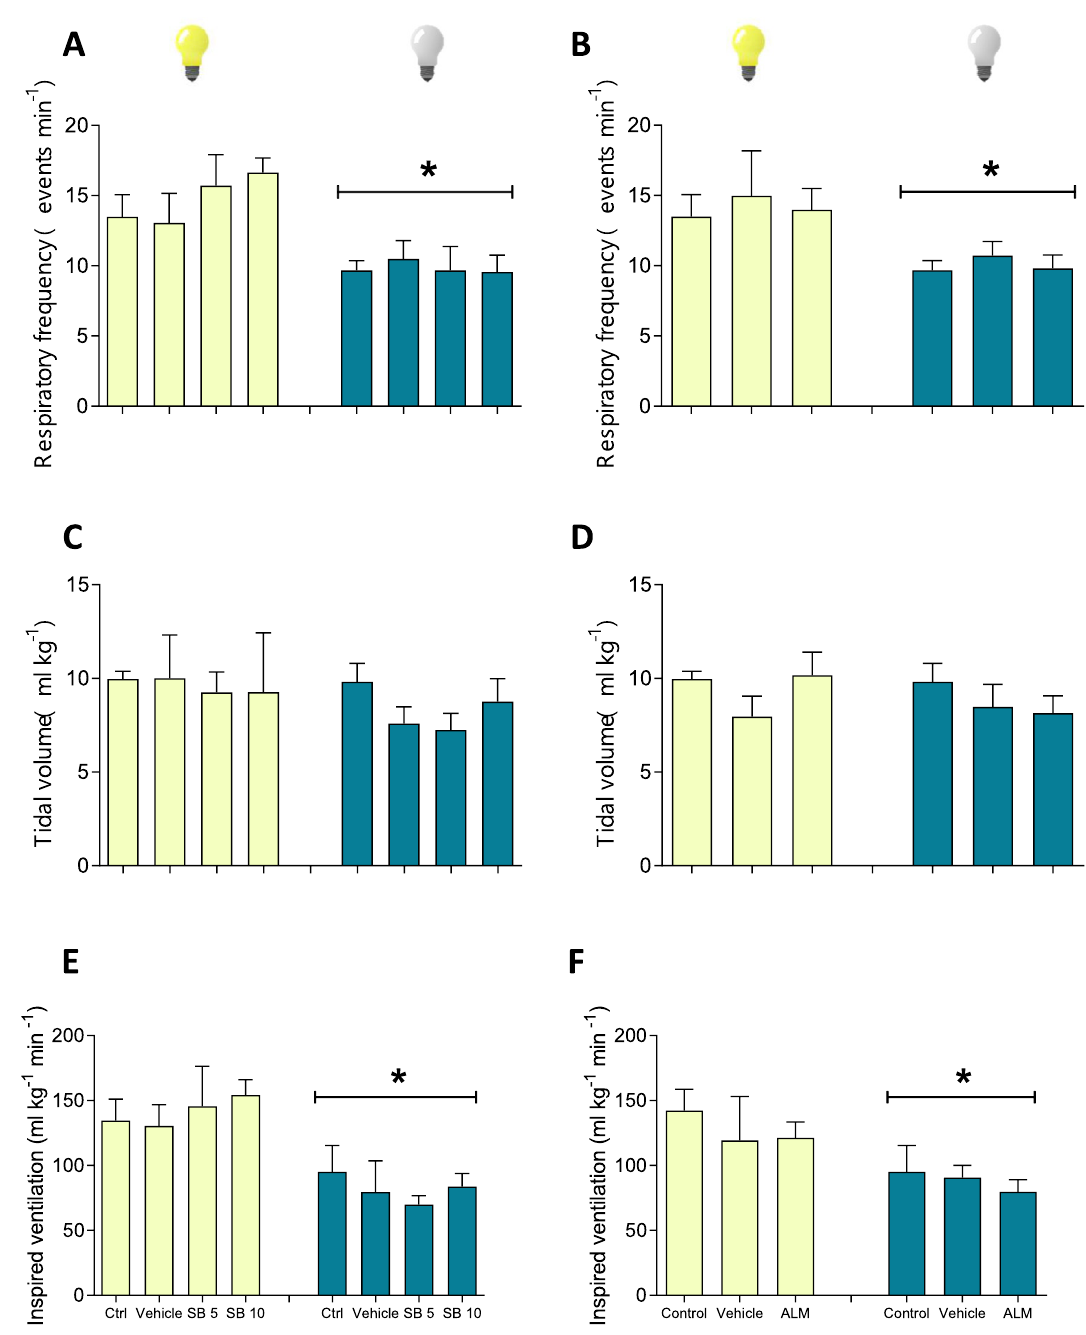
Figure 4. Effect of SB-334867 and Almorexant on basal ventilation. Effect of the i.c.v. injection of SB-334867 ˙ V and its vehicle on fR, V T and I in normocapnic normoxia in green iguanas during light or dark phases ( A ). ˙ V Effect of the i.c.v. injection of Almorexant and its vehicle on fR, V T and I in normocapnic normoxia in green iguanas during light or dark phases ( B ). * Means different from light phase at P <